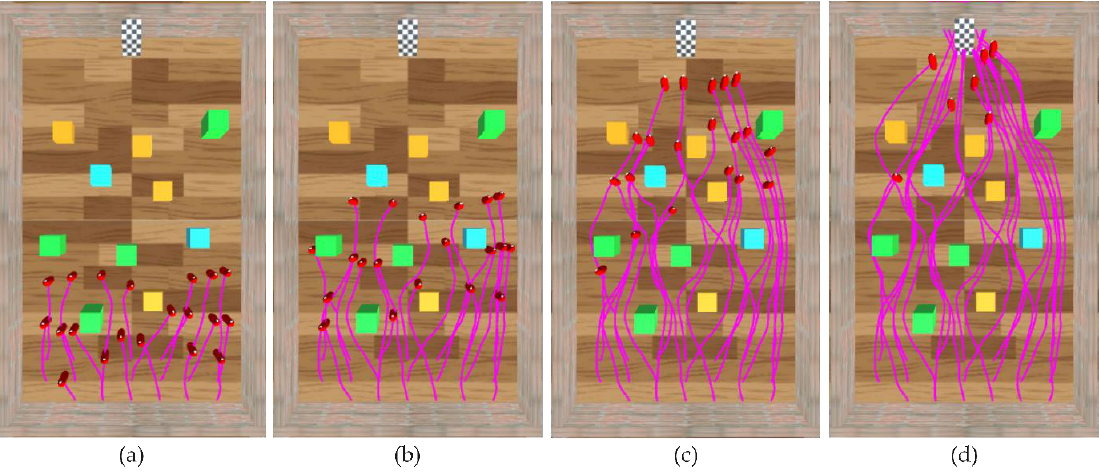
Figure 13. A temporal sequence of an experimental result generated by HDRLM3D in the adjusted scenario II. ( a – d ) Stills of the experimental result. The temporal sequence of these stills is sorted alphabetically.